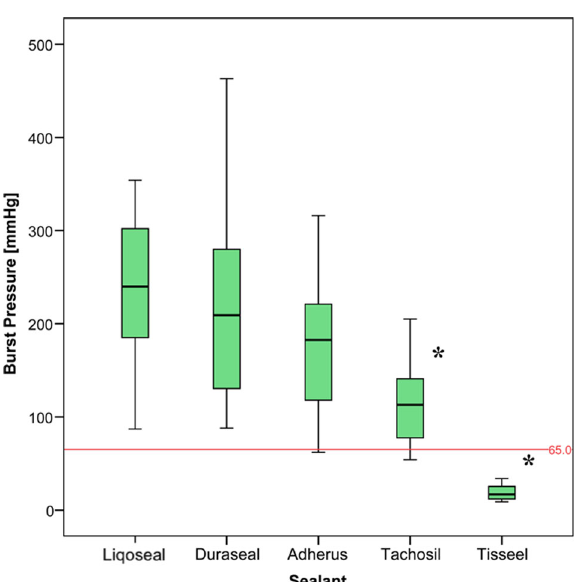
Fig. 6 Mean acute burst pressure test results concerning the sealants used in the spinal model. The red line indicates the mean physiological intracranial pressure. Asterisk indicates signi fi cant difference com- pared with